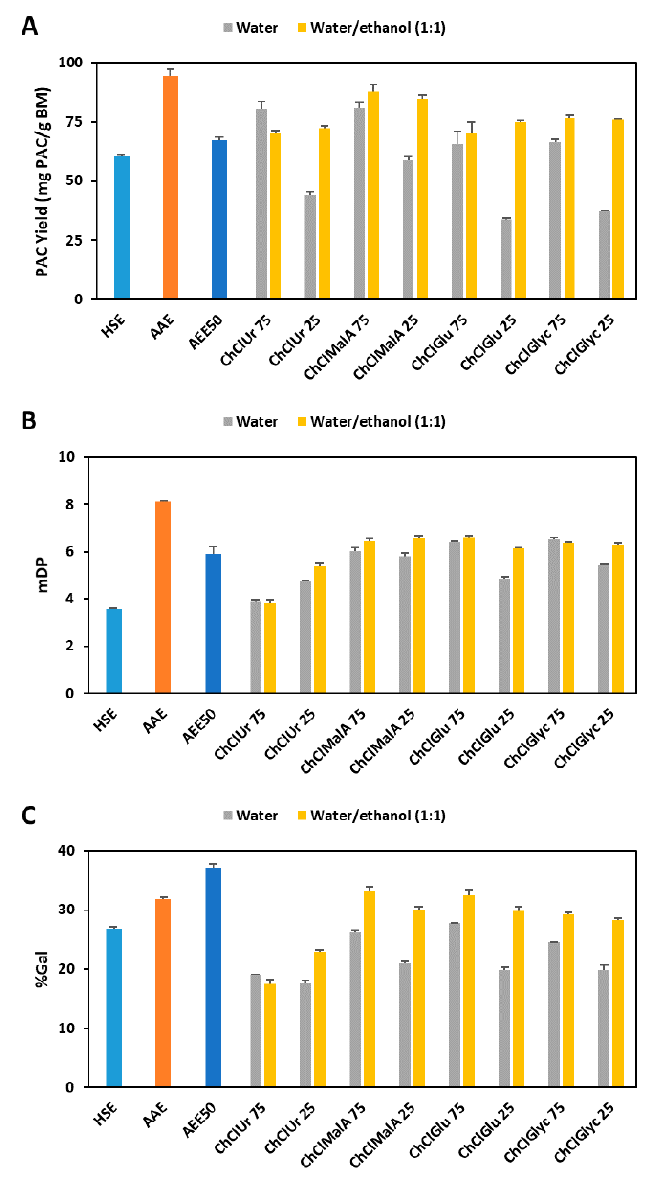
Figure 3. Comparison of Y PAC ( A ), mDP ( B ) and %Gal ( C ) between conventional solvents (HSE, AAE and AEE50) and mixtures of ES with water or water and ethanol. (ChCl—choline chloride; Ur—urea; MalA—malic acid; Glu—glucose; Glyc—glycerol; the number following ES represents its percentage).